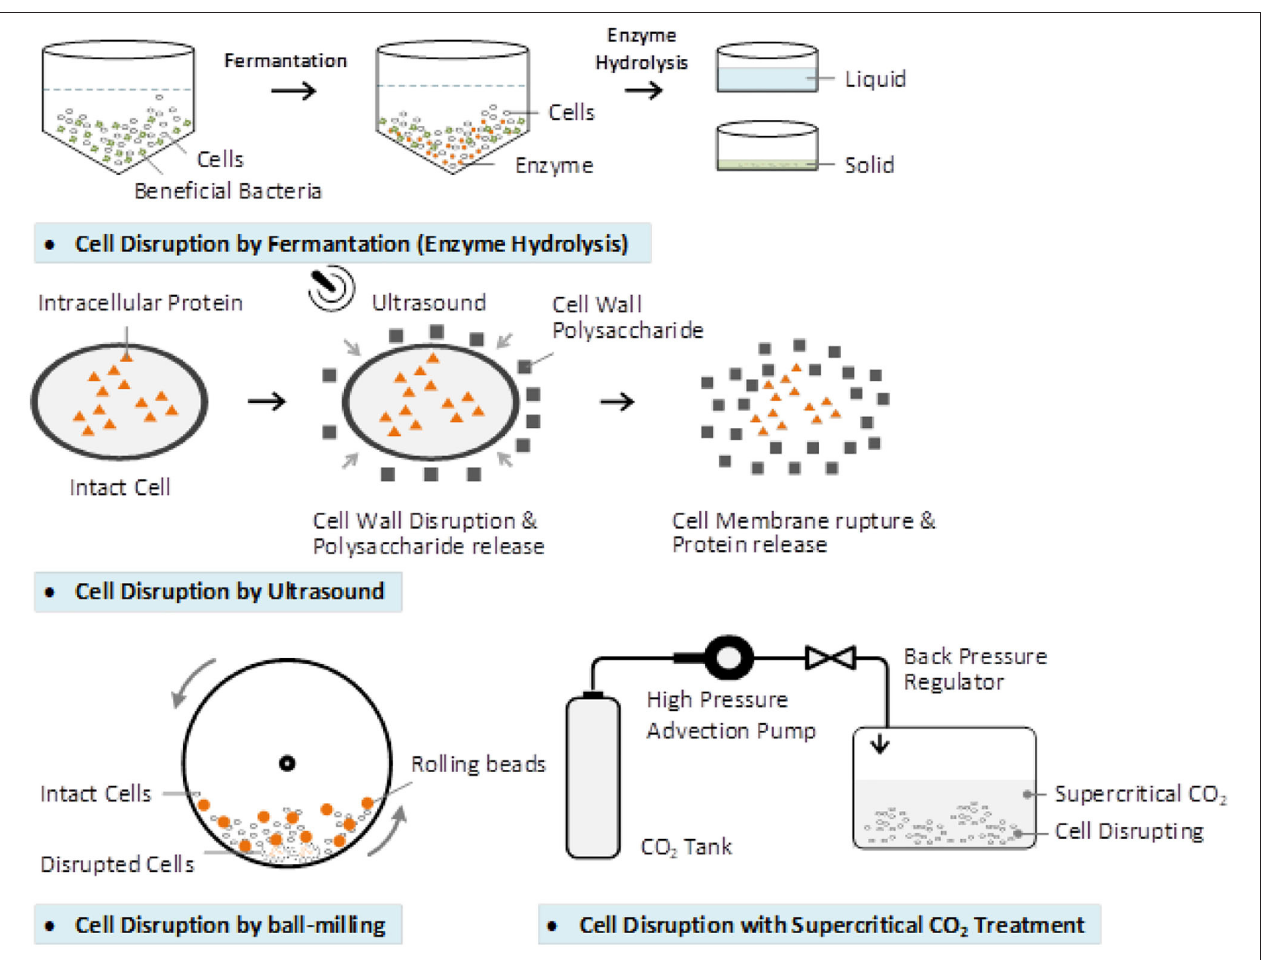
FIGURE 5 | The mechanism of wall-breaking